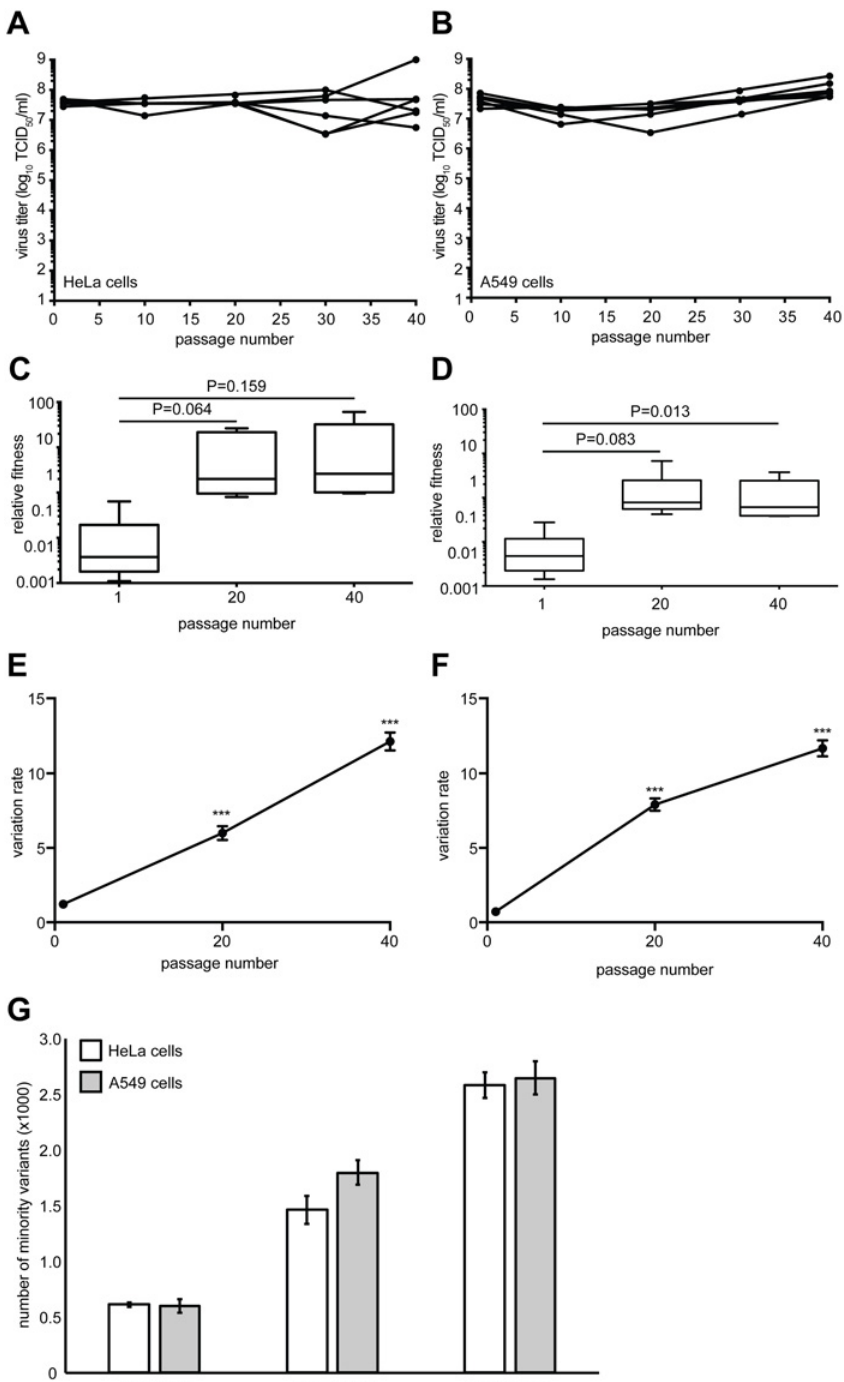
Fig 1. Virus fitness and genetic diversity increases during serial passage in both HeLa and A549 cells. HeLa (A) or A549 (B) cells were infected with CVB3 for 40 serial passages (x-axis) and virus progeny titers (y- axis) were determined for each of six replicate series. The relative fitness of each population from the HeLa (C) and A549 (D) series was compared to a non-passaged neutral competitor. Box plots show mean values and S.E.M., bars indicate minimum and maximum values, p values are indicated, student's paired t test, n = 6. The genetic diversity of each replicate was determined for passage 1, 20 and 40 populations in HeLa (E) and A549 (F) cells by calculating the variation rates at every nucleotide position. The mean variation